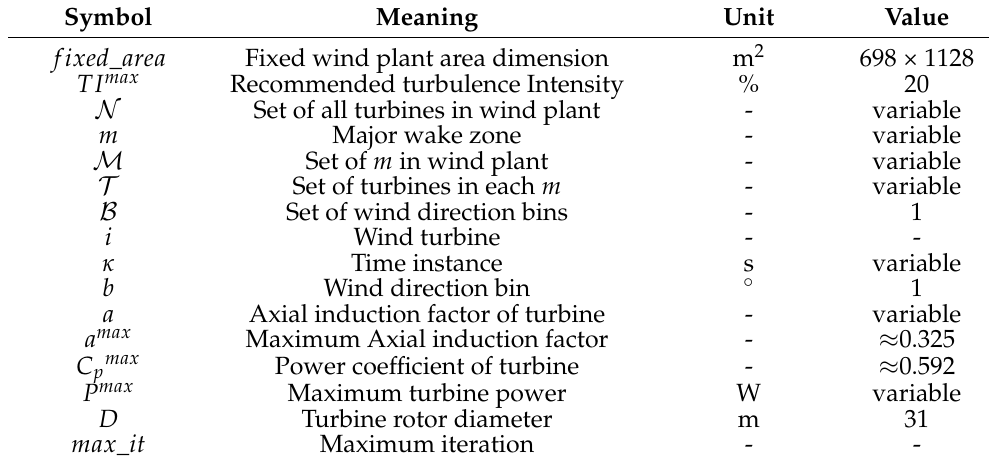
Table 6. Simulation